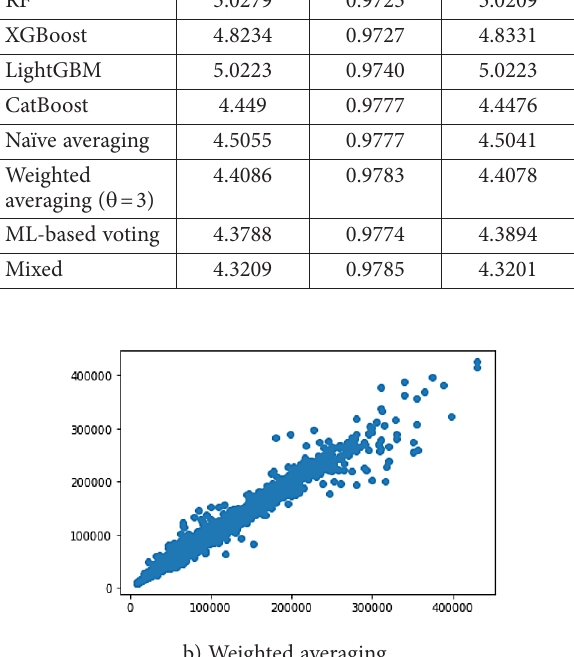
a) Naïve averaging b) Weighted averaging